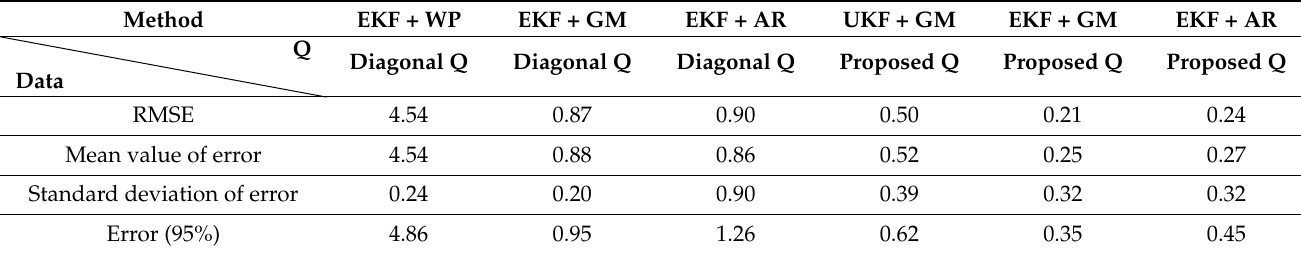
Figure 23. The PDF of the fifth scenario. Table 4. Statistical characteristics of different methods in the fifth scenario in